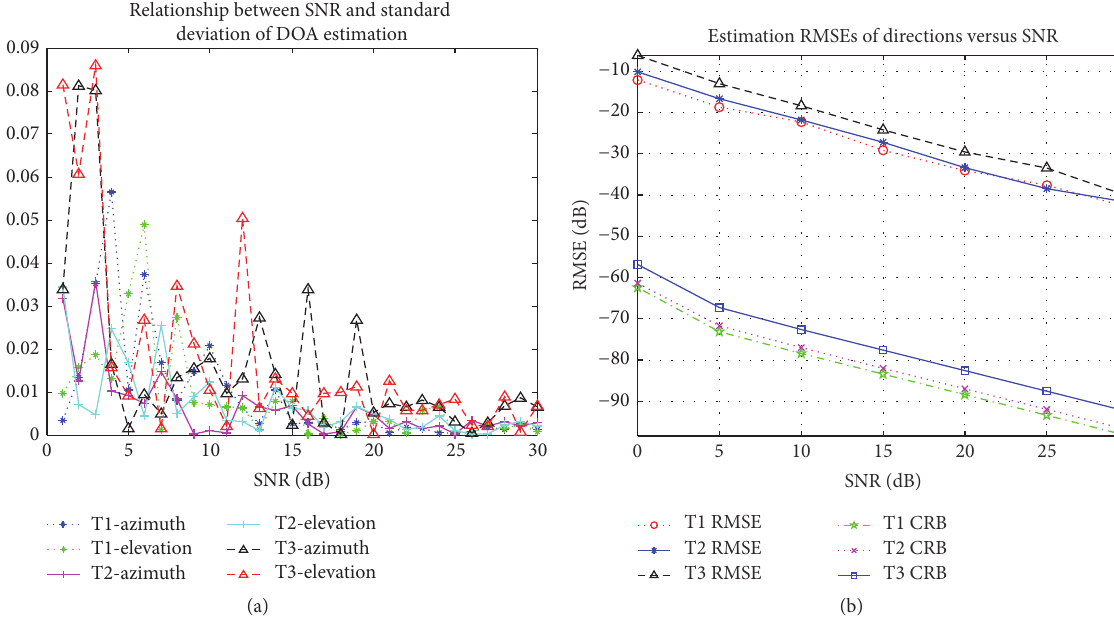
Figure 8: The DOA estimation accuracy with 𝐾 = 100 : (a) deviation of estimates versus SNR and (b) the RMSE and CRB versus